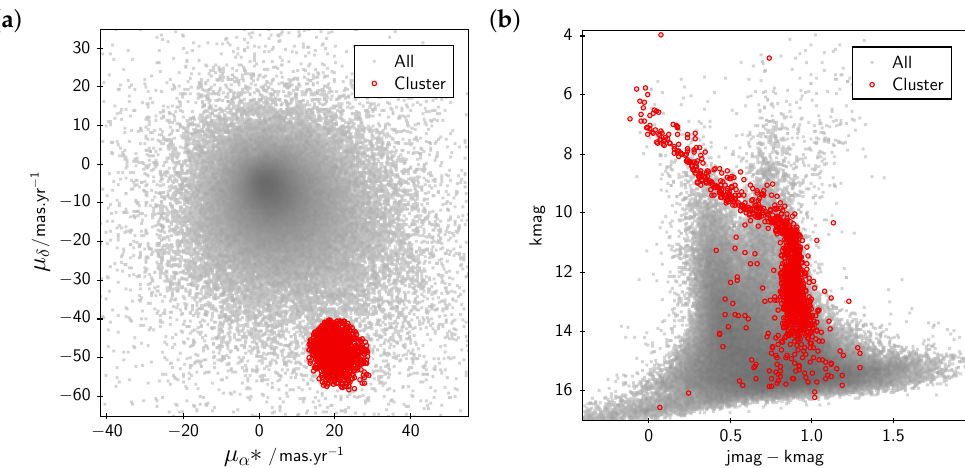
Figure 2. Linked views for row subsets. The user has identified the region in plot ( a ) by dragging the mouse, and the same subset of rows shows up in an interesting subregion of the different plot in ( b ). In this case each point represents a star in the region of the Pleiades open cluster [17]; ( a ) shows apparent velocity across the sky, while ( b ) characterises stellar classification. Those stars with similar motion, identified as the “Cluster” subset in ( a ), were formed in the same environment and therefore have similar physical characteristics, hence trace out a distinct path in ( b